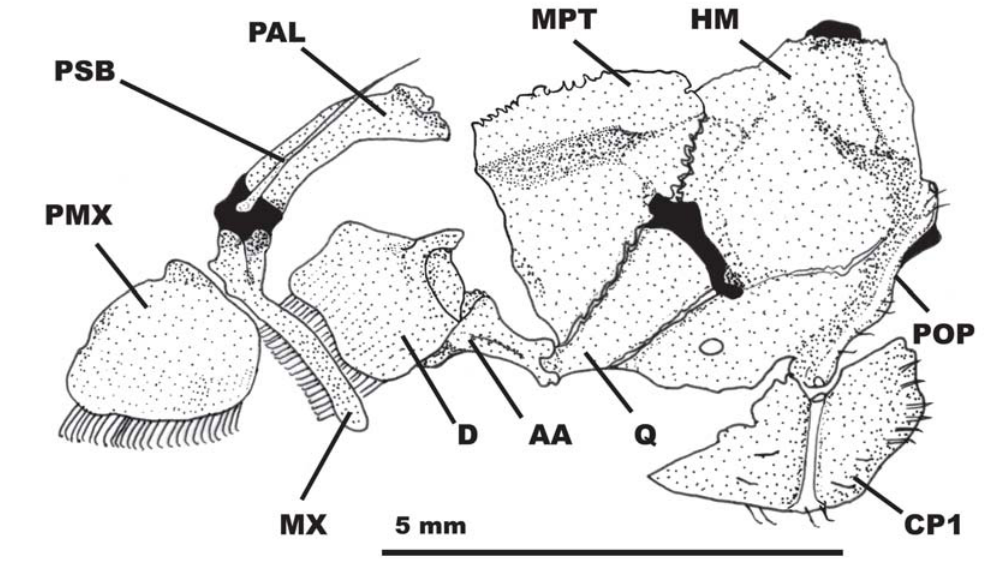
Fig. 9. Suspensorium in lateral view of Gymnotocinclus anosteos , MCP 41726, paratype, male, 40.5 mm.